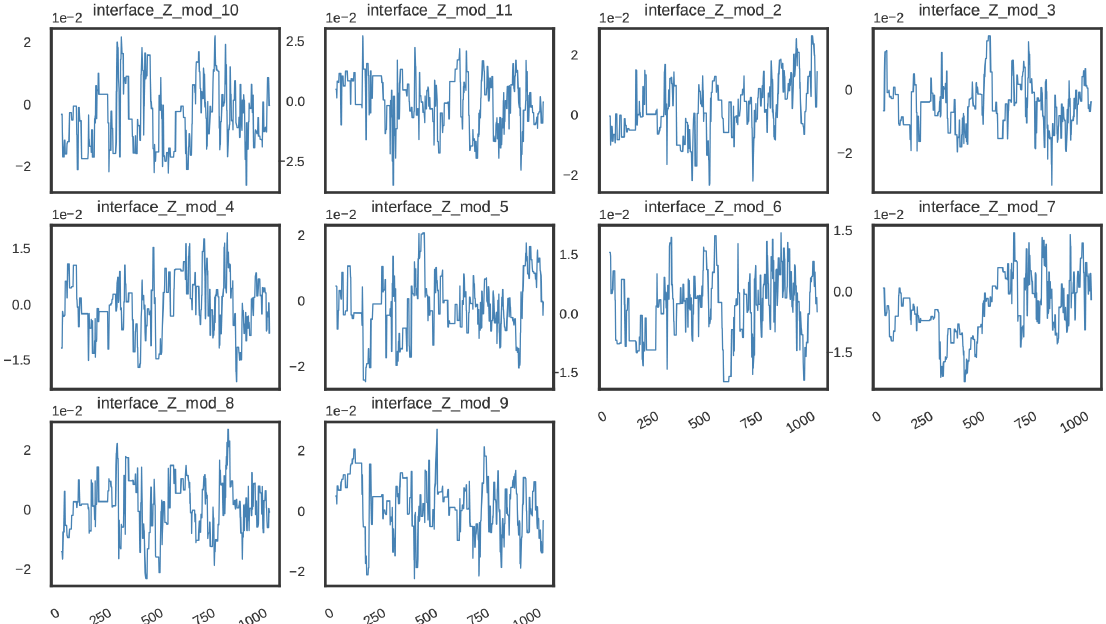
Figure E2. Traces of the parameters belonging to the inference with all likelihoods. The asymptotic behavior probes ergodicity. The first 1000 iterations (not displayed here) were used as burn-in and are not represented